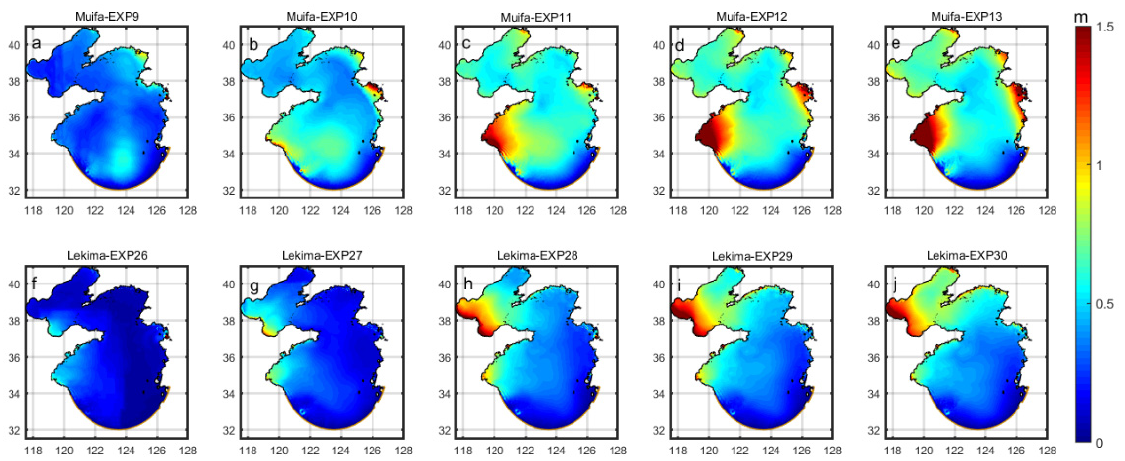
Figure 13. Spatial distribution of the storm surge when the RMW was ( a ) 10 km, ( b ) 20 km, ( c ) 30 km, ( d ) 40 km, and ( e ) 50 km based on Typhoon Muifa and ( f ) 10 km, ( g ) 20 km, ( h ) 30 km, ( i ) 40 km, and ( j ) 50 km based on Typhoon Lekima.